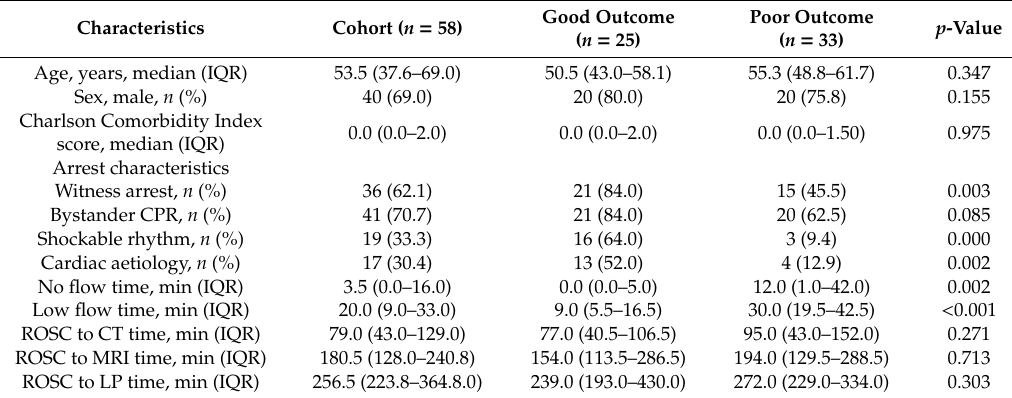
Table 2. NSE levels of serum and cerebrospinal fluid (CSF), grey-to-white matter ratio (GWR), high